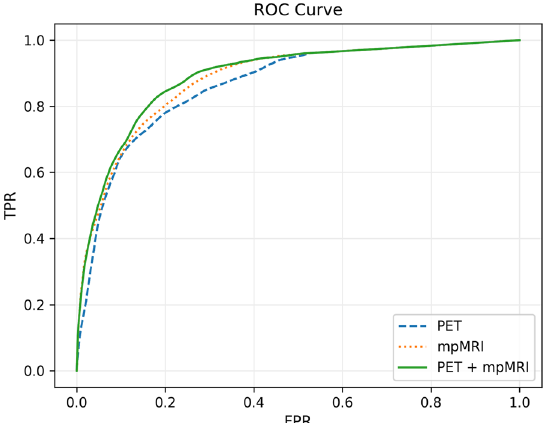
Fig. 3 ROC curves for each of the tumour detection models. TPR True positive rate, FPR False positive rate